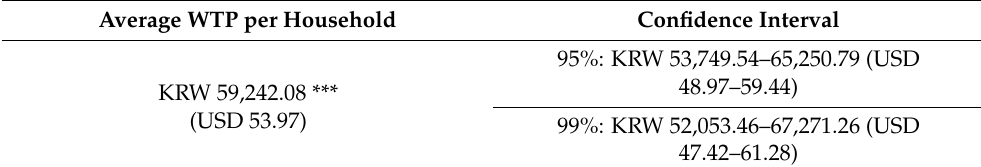
Table 5. Average willingness to pay per household.